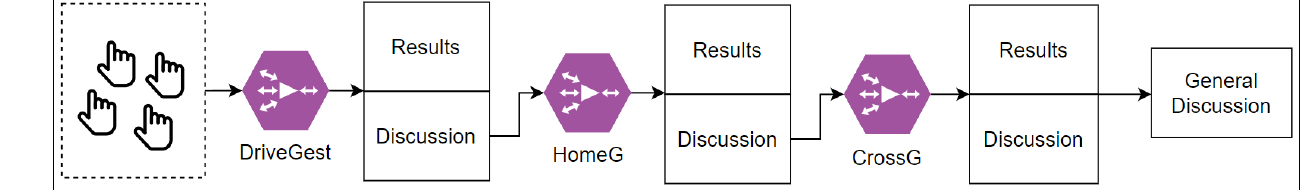
Figure 2. The analysis steps of the study. Table 4. Gesture code, function, and description for HomeG for controlling home AC system.